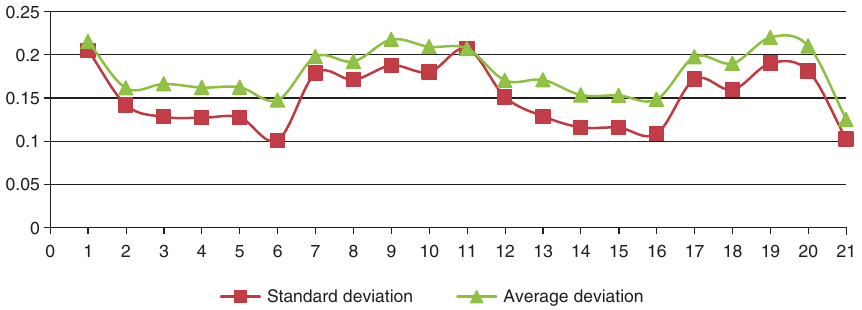
Figure 5: Standard/Average Deviation Results for Proposed 21 Measures on Score Classes 2–3 with MSR